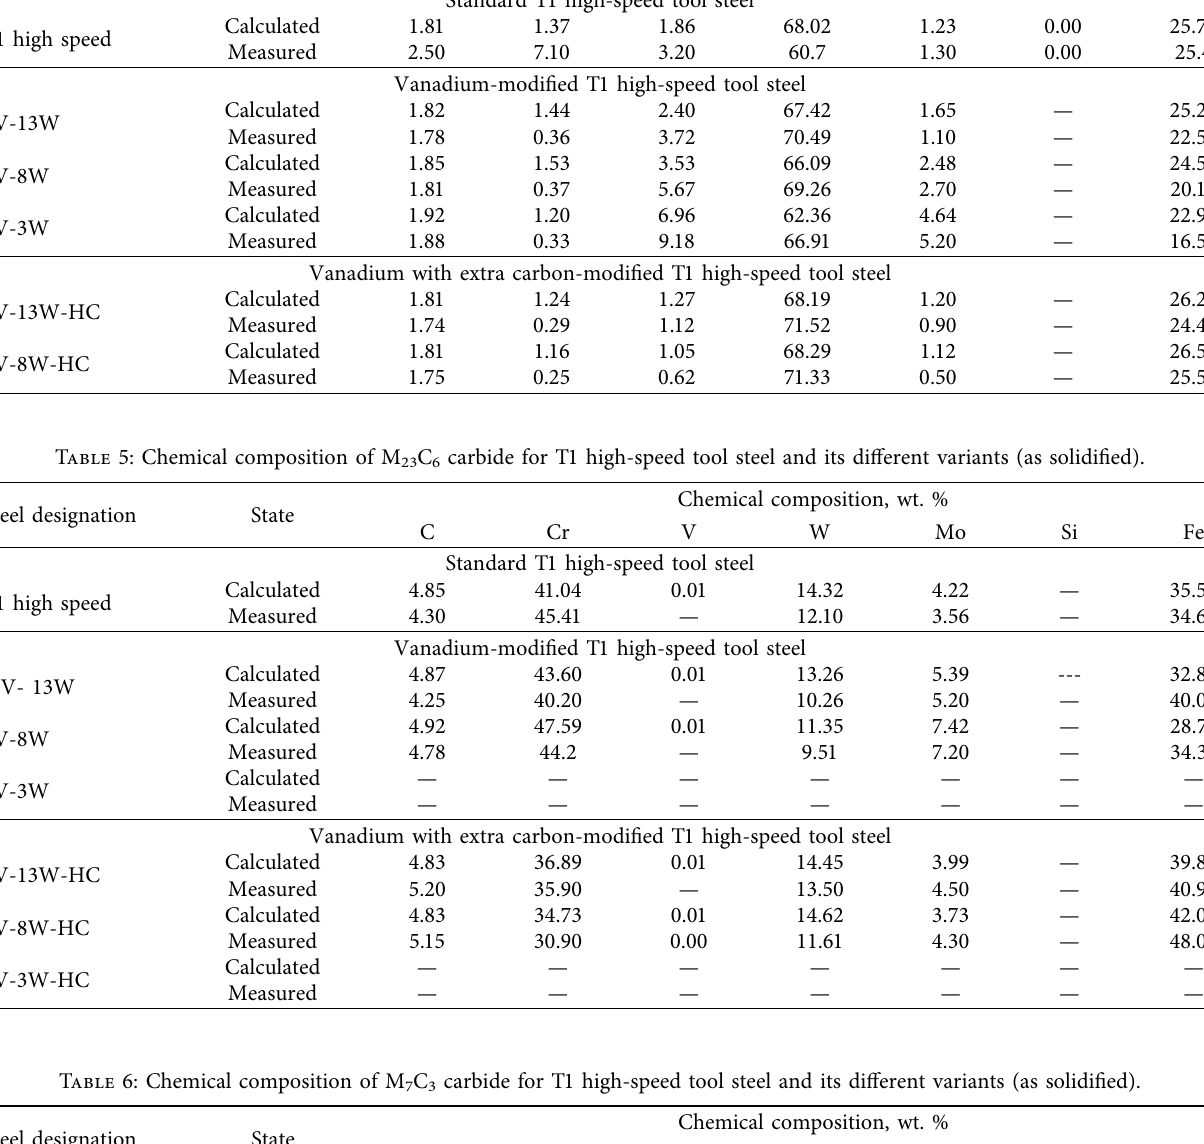
Table 4: Chemical composition of M Steel designation T1 high speed